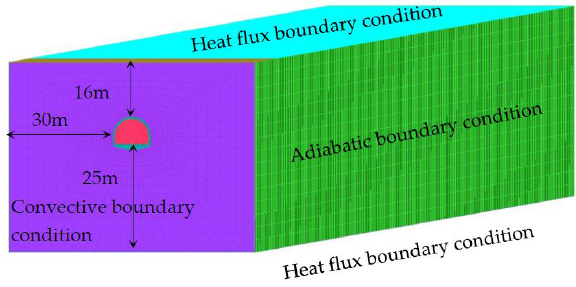
Figure 7. Employed three-dimensional model for the Dege tunnel.